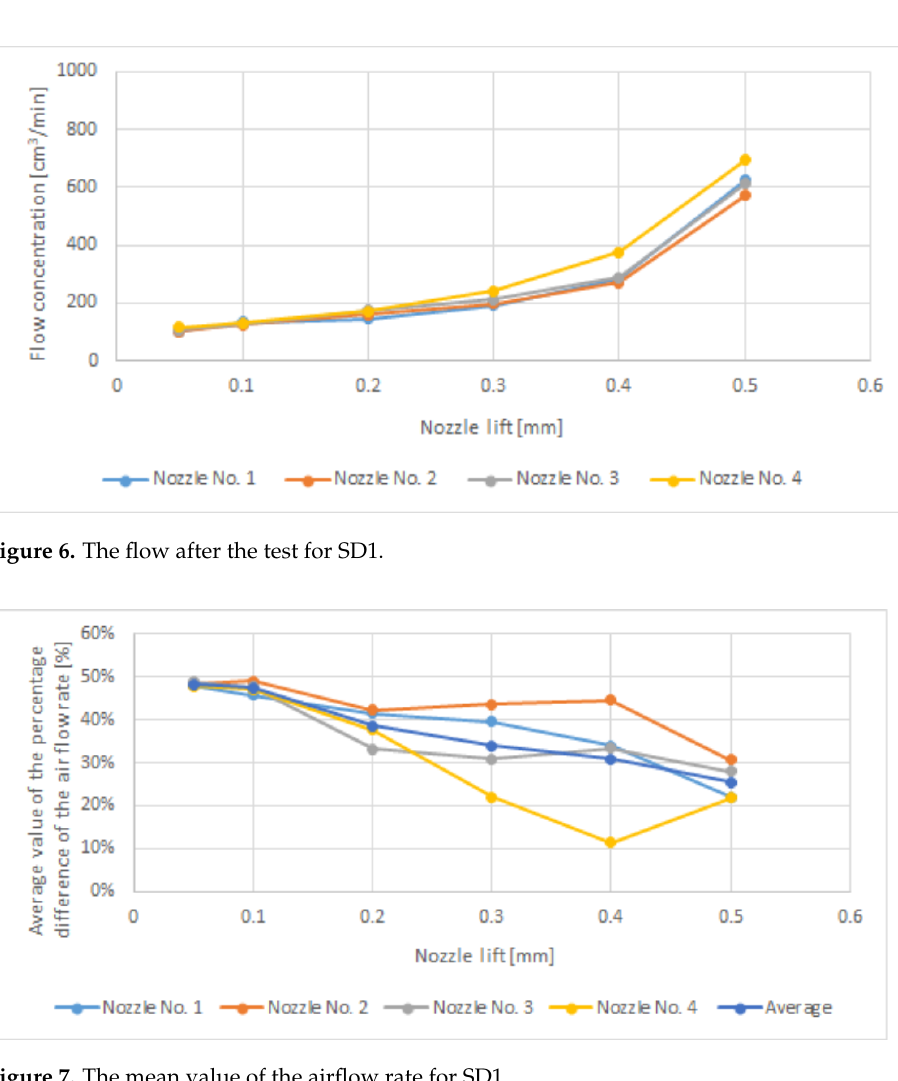
Figure 7. The mean value of the airflow rate for SD1.